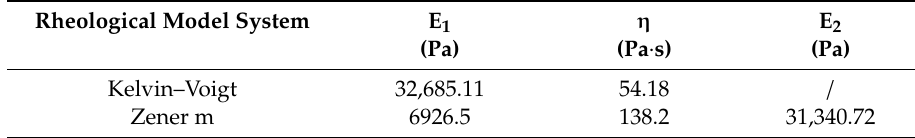
Table 9. Spring moduli and dashpot viscosities for Maxwell, Kelvin–Voigt, and Zener m model. Rheological Model